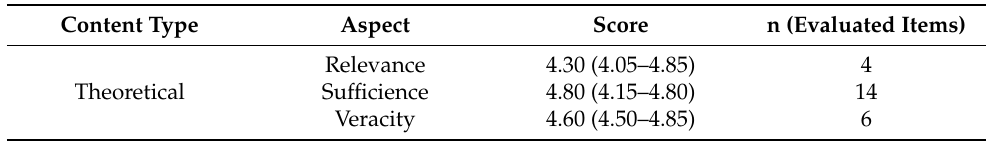
Table 6. Delphi validation results of the “Anatomy and Physiology” model, organized by aspects evaluated and scored from 1 to